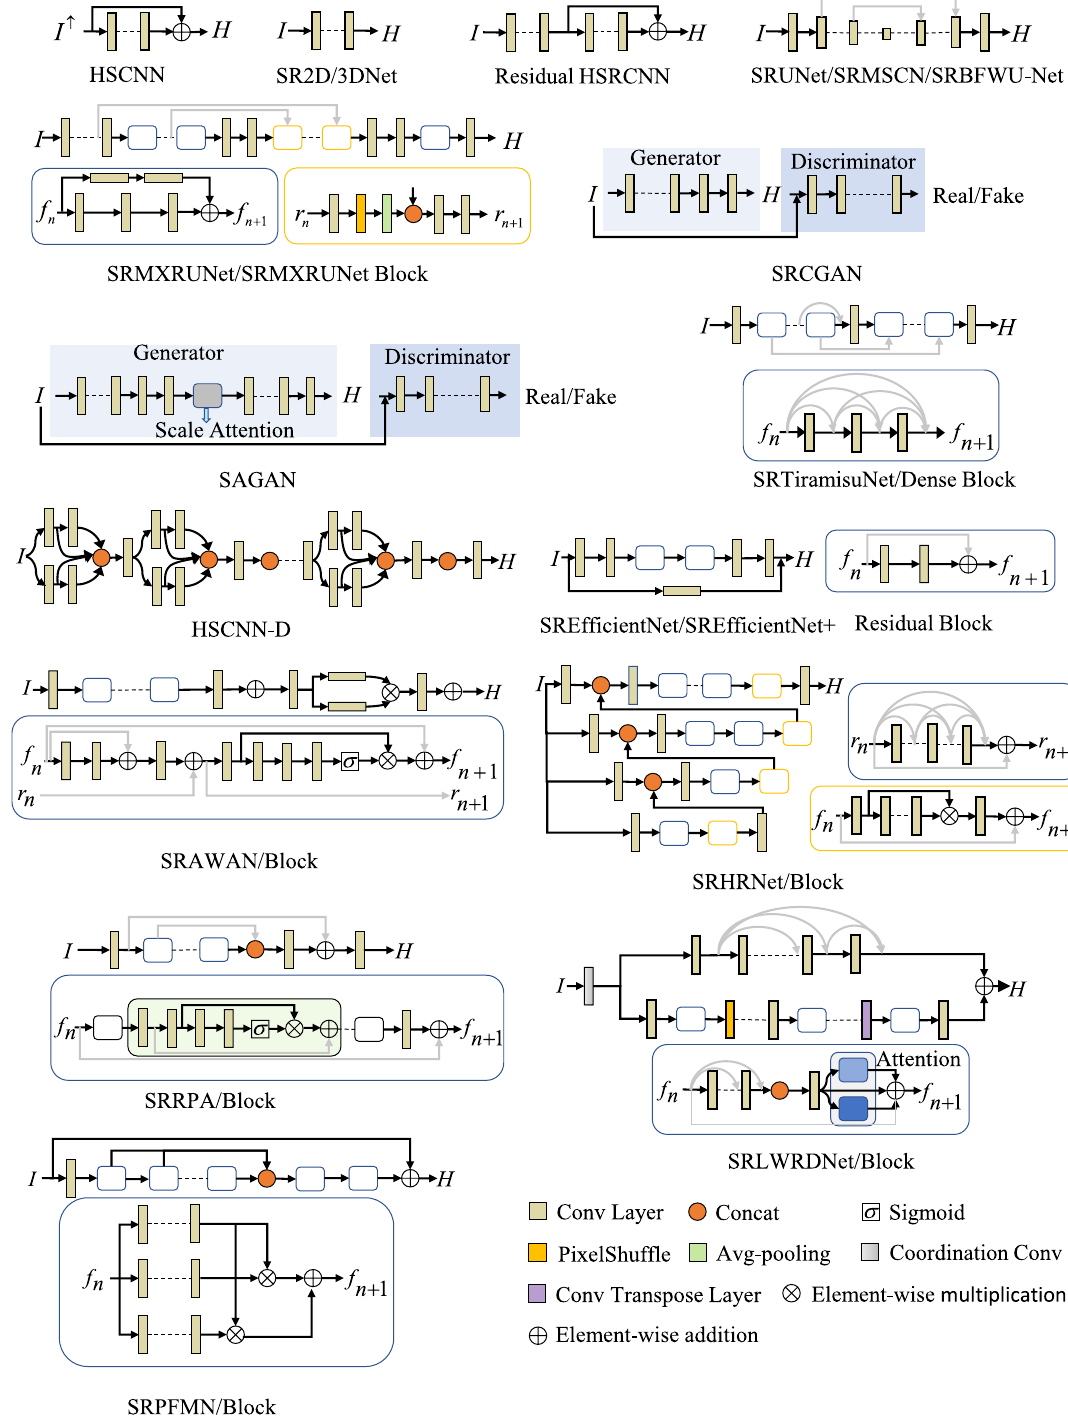
Figure 3. A glimpse of various deep neural network architectures used for spectral reconstruction from RGB images. I ↑ represents the RGB image is upsampled in the spectral domain so that the 3D dimension is consistent with the H